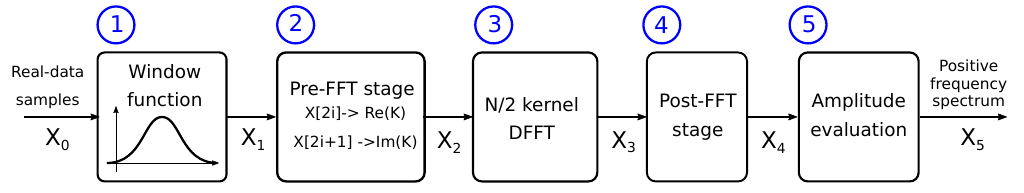
Figure 1. Flowchart of the optimized algorithm for the frequency spectrum